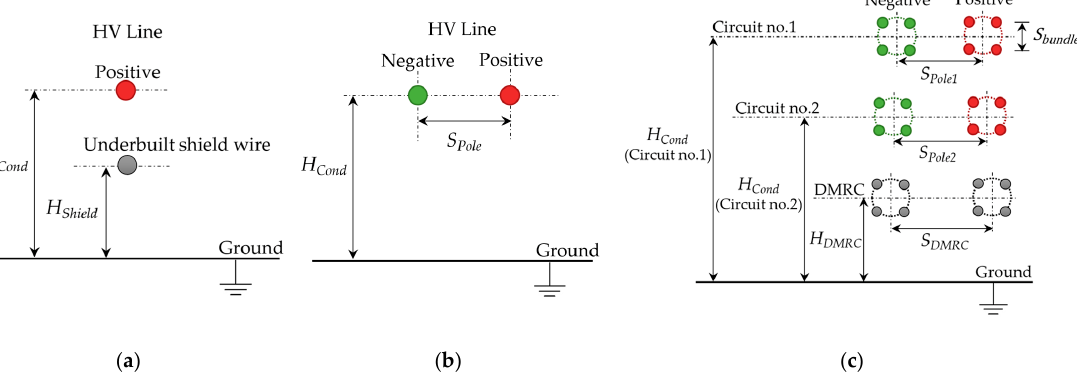
Figure 2. Configurations of calculation: ( a ) + 70 kV reduced scale; ( b ) ±250 kV full scale; ( c ) ±500 kV full scale. Table 1. Geometrical parameters of the configurations.